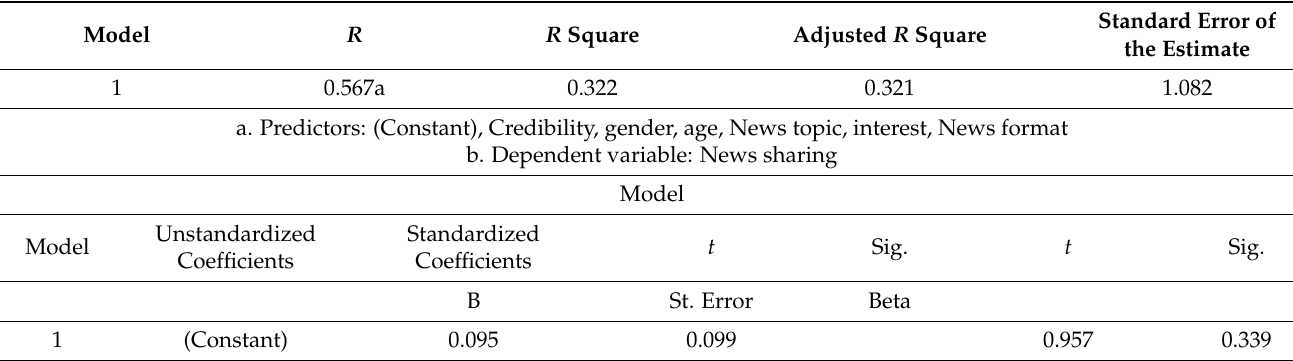
Table 9. Multiple Linear Regression. Likelihood of sharing as dependent